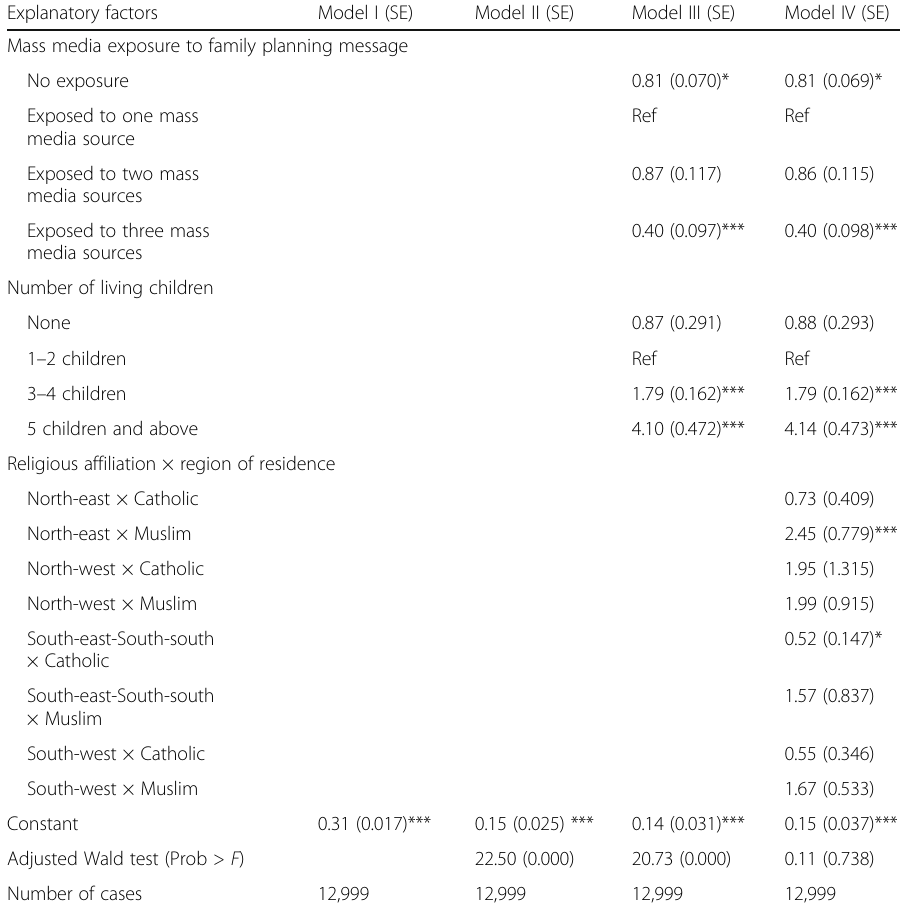
Table 3 Odds ratios of the association of unintended births with religion, region of residence, and other covariates among women in Nigeria (NDHS 2018) (Continued) Explanatory